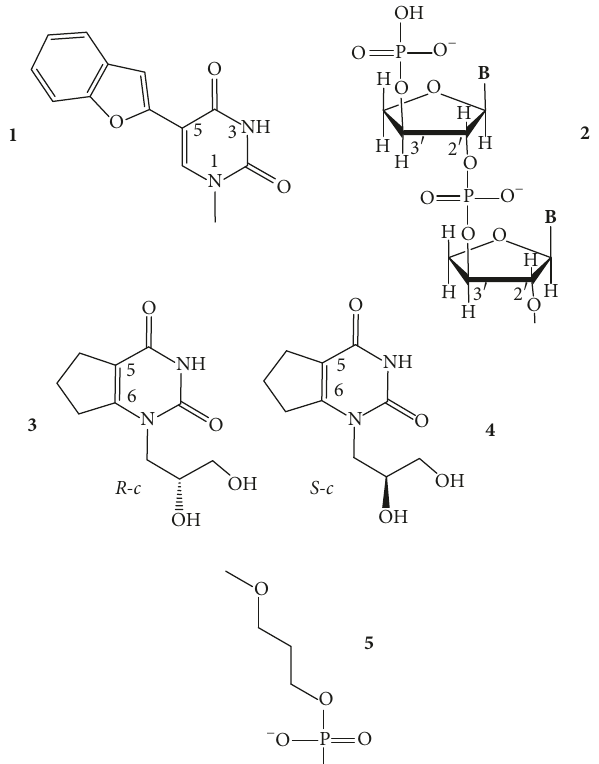
Figure 5: Structures of 5-(benzofuran-2-yl)uracil ( 1 ); threose dinucleotide ( 2 ); R- ( 3 ) and S-isomer ( 4 ) of acyclic-uracil derivatives and the n-propyl spacer ( 5